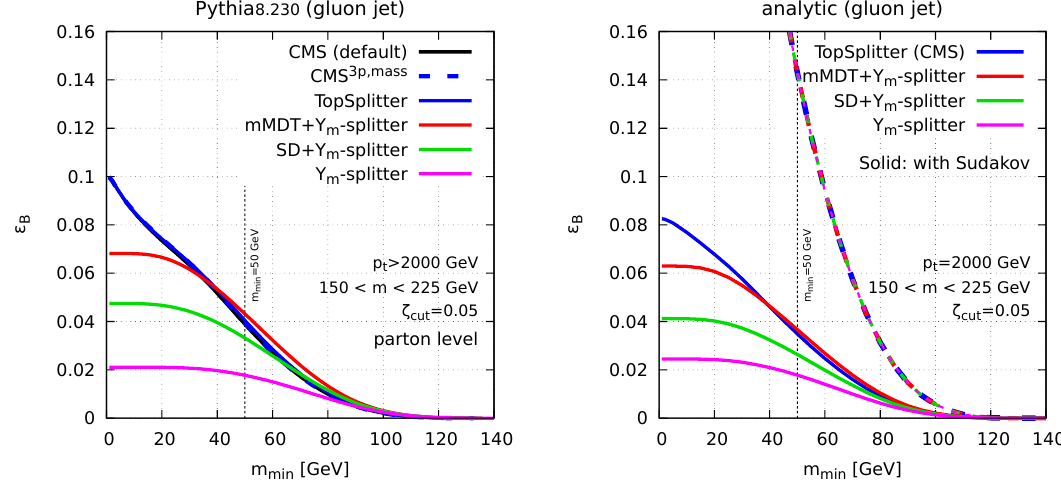
Figure 8. Same as (cid:12)gure 7 but this time for gluon-initiated jets. Also shown in the analytic calculations on the right is the result without the application of the Sudakov form factors, using just the pre-factor from the triple-collinear splitting function for an initial